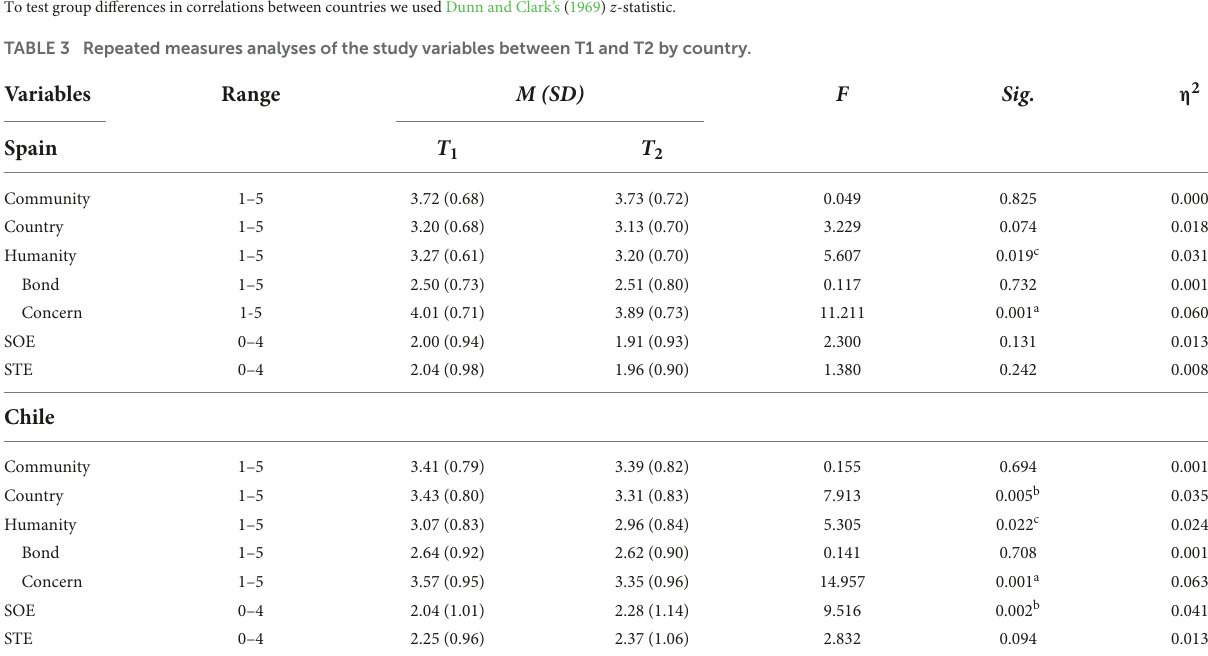
TABLE 3 Repeated measures analyses of the study variables between T1 and T2 by country.